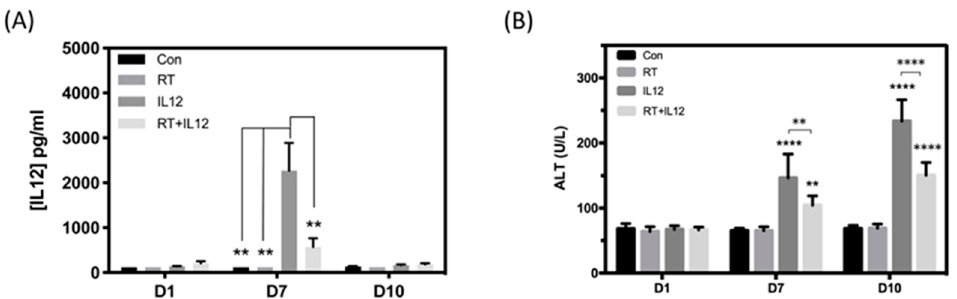
Figure 4. Combined modality therapy reduced the IL-12-induced toxicity on normal tissues. ( A ) The amount of IL-12 in plasma at days 1, 7, and 10 post treatment was quantified by ELISA assay. n = 3 in each group at day 1 and n ≥ 4 in each group at days 7 and 10. ( B ) The level of ALT in plasma was measured to assess the liver damage induced by IL-12 treatment. n ≥ 5 in each group. ** p < 0.01, **** p < 0.0001.